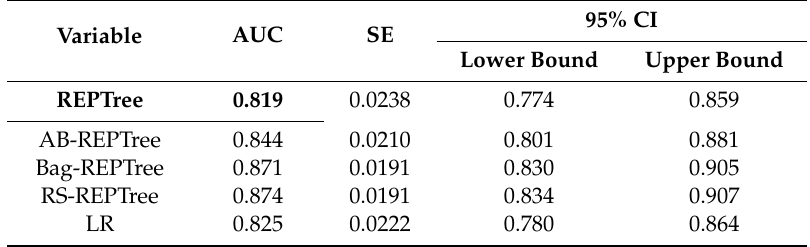
Table 7. ROC curve using the training